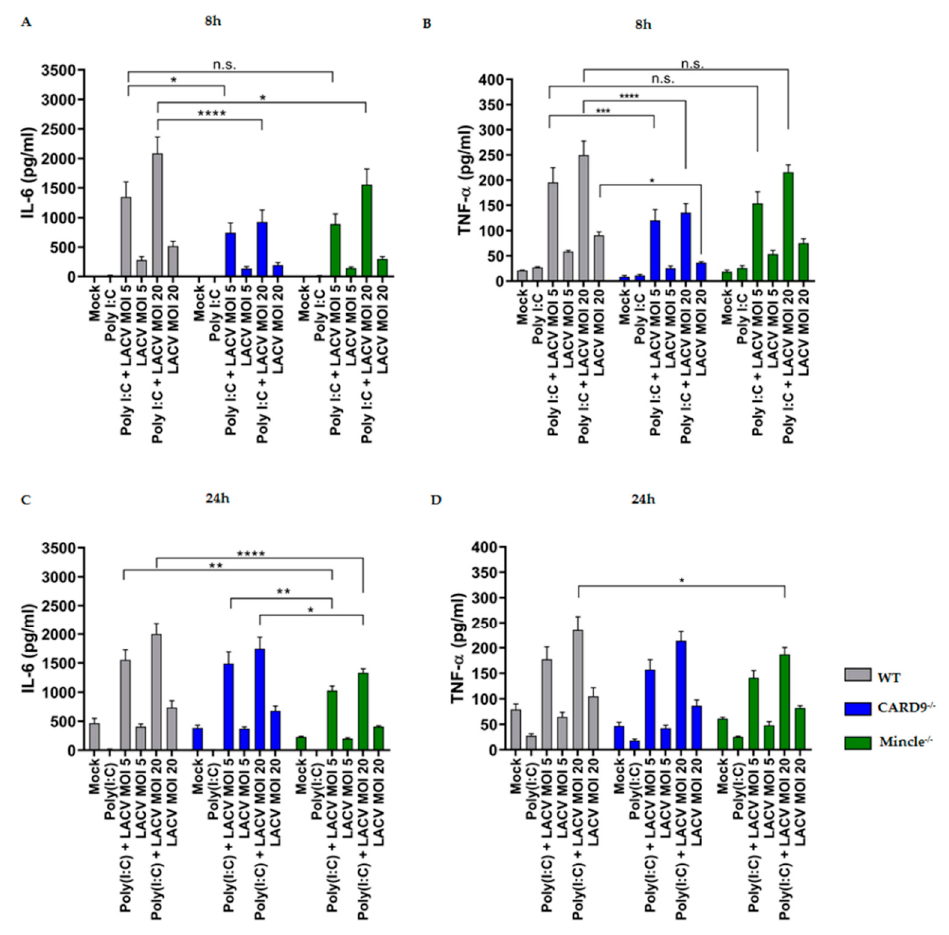
Figure 5. Mincle − / − and CARD9 − / − DCs display impaired proinflammatory cytokine production upon LACV challenge in the presence of Poly(I:C). IL-6 and TNF- α production after 8 h ( A , B , respectively) and 24 h of stimulation ( C , D , respectively). Data represented are mean ± SEM of three independent experiments. A two-way ANOVA with a Tukey’s honest significance test was performed and p < 0.05 was considered significant (* p < 0.05, ** p < 0.01, *** p < 0.001, **** p < 0.0001).